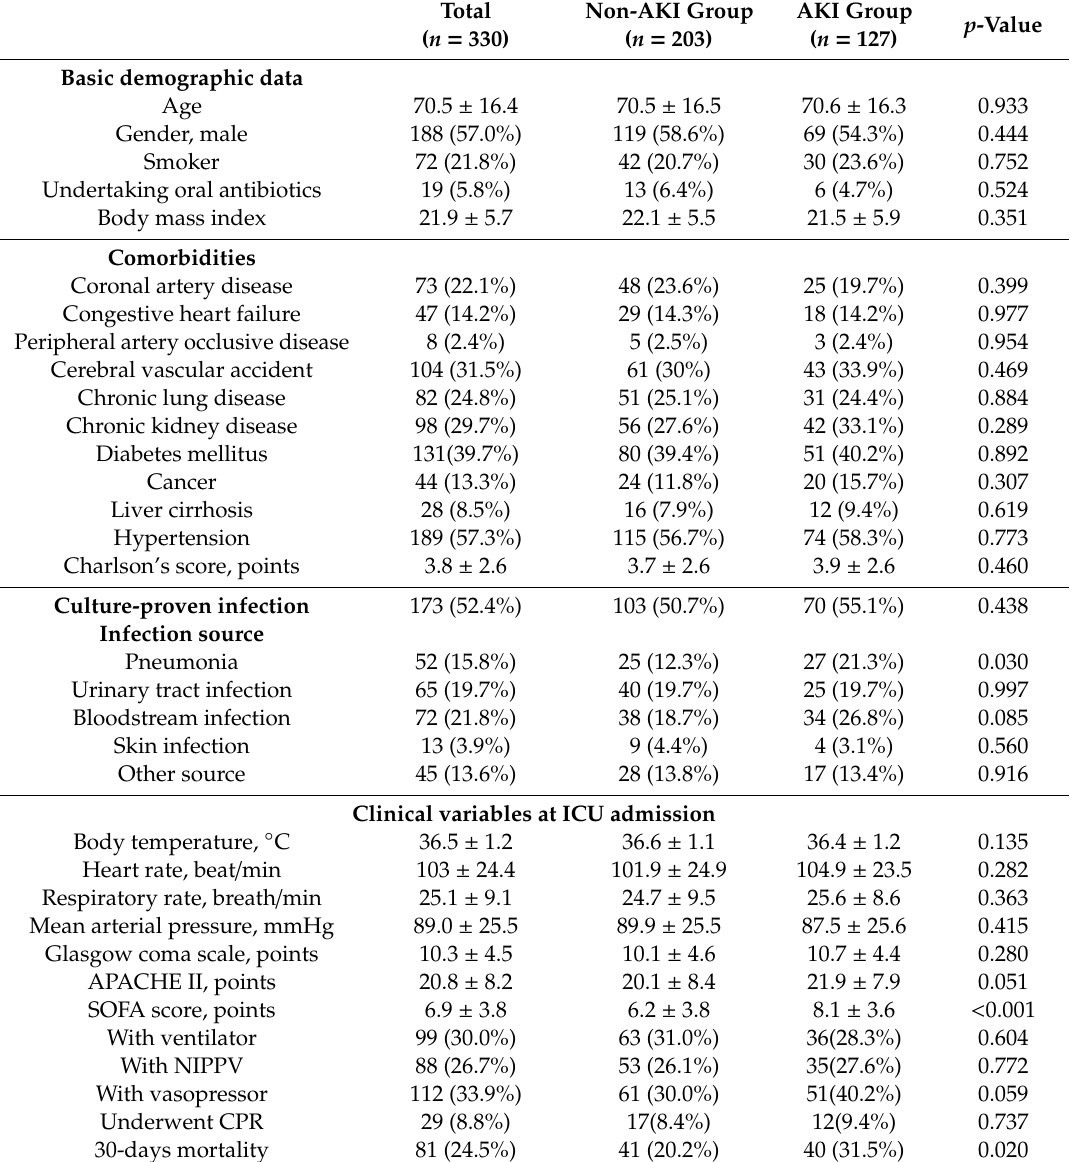
Table 1. Comparisons of basic characteristics and clinical variables of the two